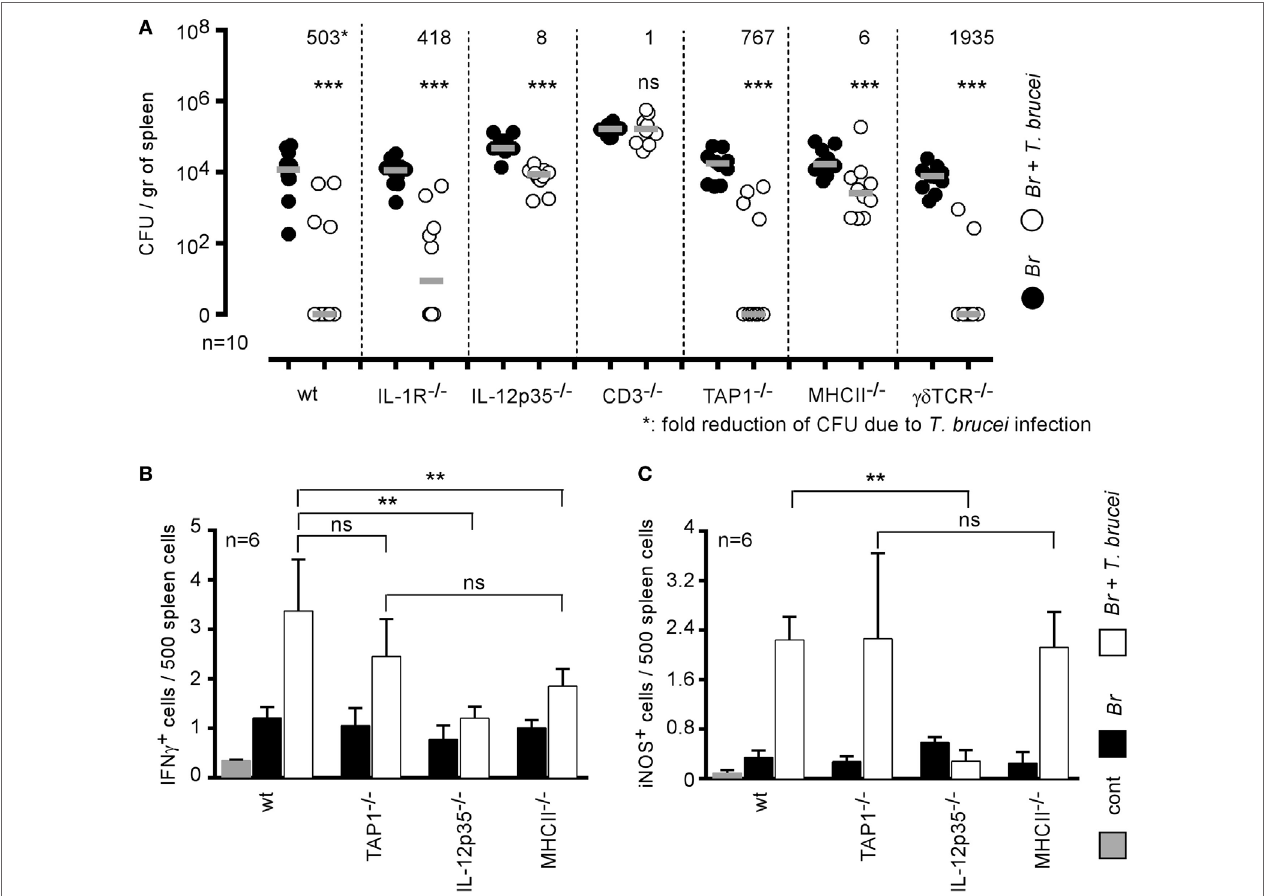
FigUre 5 | Elimination of Brucella during Trypanosoma brucei infection required IL-12 and CD4 + T cells. (a) Wild-type and various genetically deficient C57BL/6 mice were infected i.n. with 2 × 10 4 CFU of mCherry- Brucella melitensis and, at 7 days postinfection, received an i.p. injection of 5,000 T. brucei in 200 µl of PBS (co-infection group) or PBS alone ( B. melitensis group). The mice were euthanized at 28 days post Brucella infection, and the spleen was harvested (a) . The data represent the number of colony-forming units per gram of spleen. Gray bars represent the median. n denotes the number of mice used for each group. (B,c) The data represent the frequency of IFN γ - and iNOS-producing cells in the spleen as determined by flow cytometry analysis. The control (cont) group consisted of naive mice receiving PBS only (** p < 0.01, *** p < 0.001). These results are representative of at least two independent